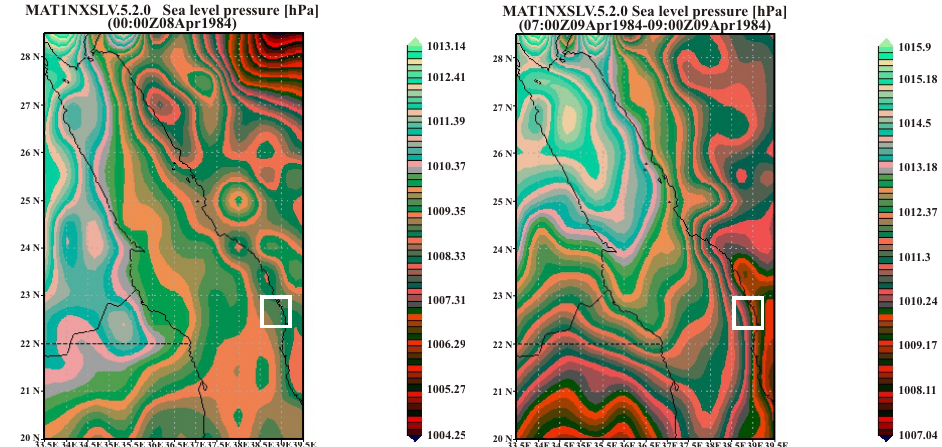
Fig. A2. Sea level pressure related to STS41C NASA mission 0a.m.–1p.m. on 9 April 1984 (white square corresponds to Fig.